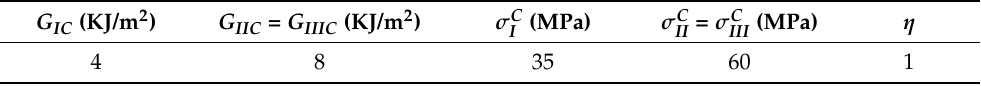
Table 3. Cohesive zone properties used in the modeling of fiber tow/matrix interface.